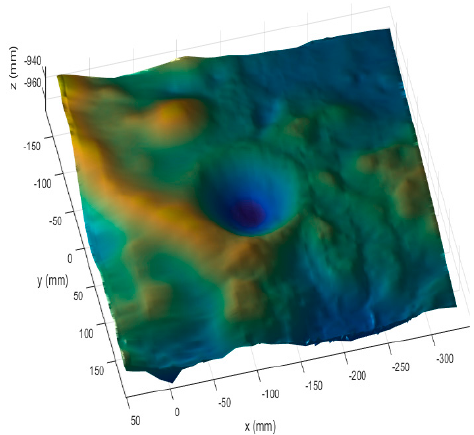
Figure 9. The rendering of the surface topography after triangulation of the point cloud and surface fitting.